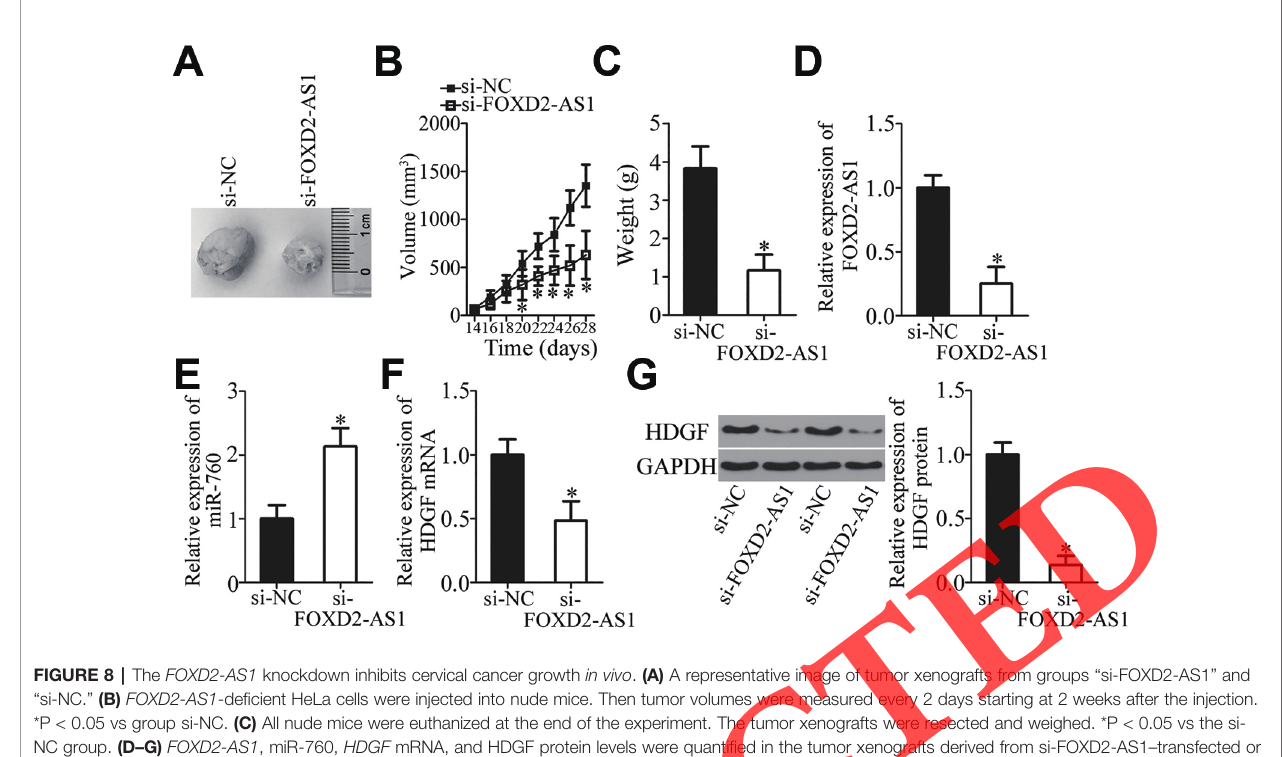
FIGURE 8 | The FOXD2-AS1 knockdown inhibits cervical cancer growth in vivo . (A) A representative image of tumor xenografts from groups “ si-FOXD2-AS1 ” and “ si-NC. ” (B) FOXD2-AS1 -de fi cient HeLa cells were injected into nude mice. Then tumor volumes were measured every 2 days starting at 2 weeks after the injection. *P < 0.05 vs group si-NC. (C) All nude mice were euthanized at the end of the experiment. The tumor xenografts were resected and weighed. *P < 0.05 vs the si- NC group. (D – G) FOXD2-AS1 , miR-760, HDGF mRNA, and HDGF protein levels were quanti fi ed in the tumor xenografts derived from si-FOXD2-AS1 – transfected or si-NC – transfected HeLa